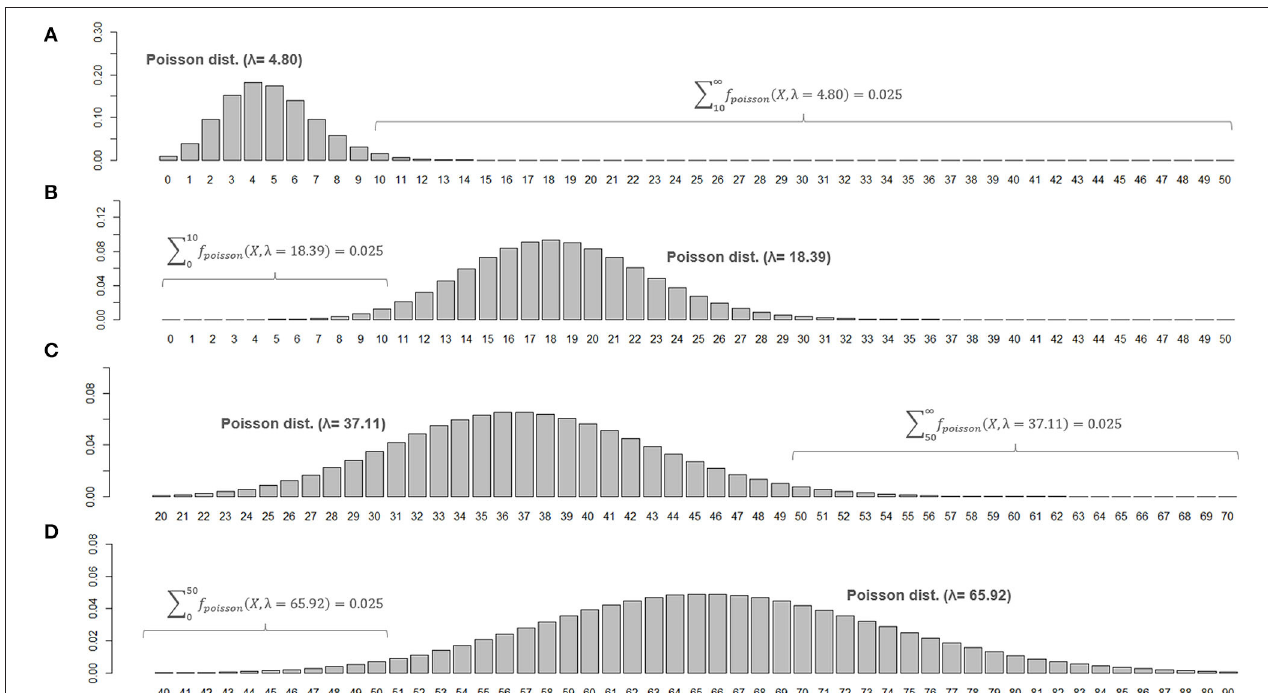
FIGURE 3 | Poisson distributions of different means and 95% CIs for the parameter λ . Poisson distributions of different means that realize an upper or lower cumulative probability of 0.025, with the number of observed events ( X ) at 10 (A,B) or 50 (C,D) , are shown. To be noted, the ranges for horizontal axis are different between (C,D) .